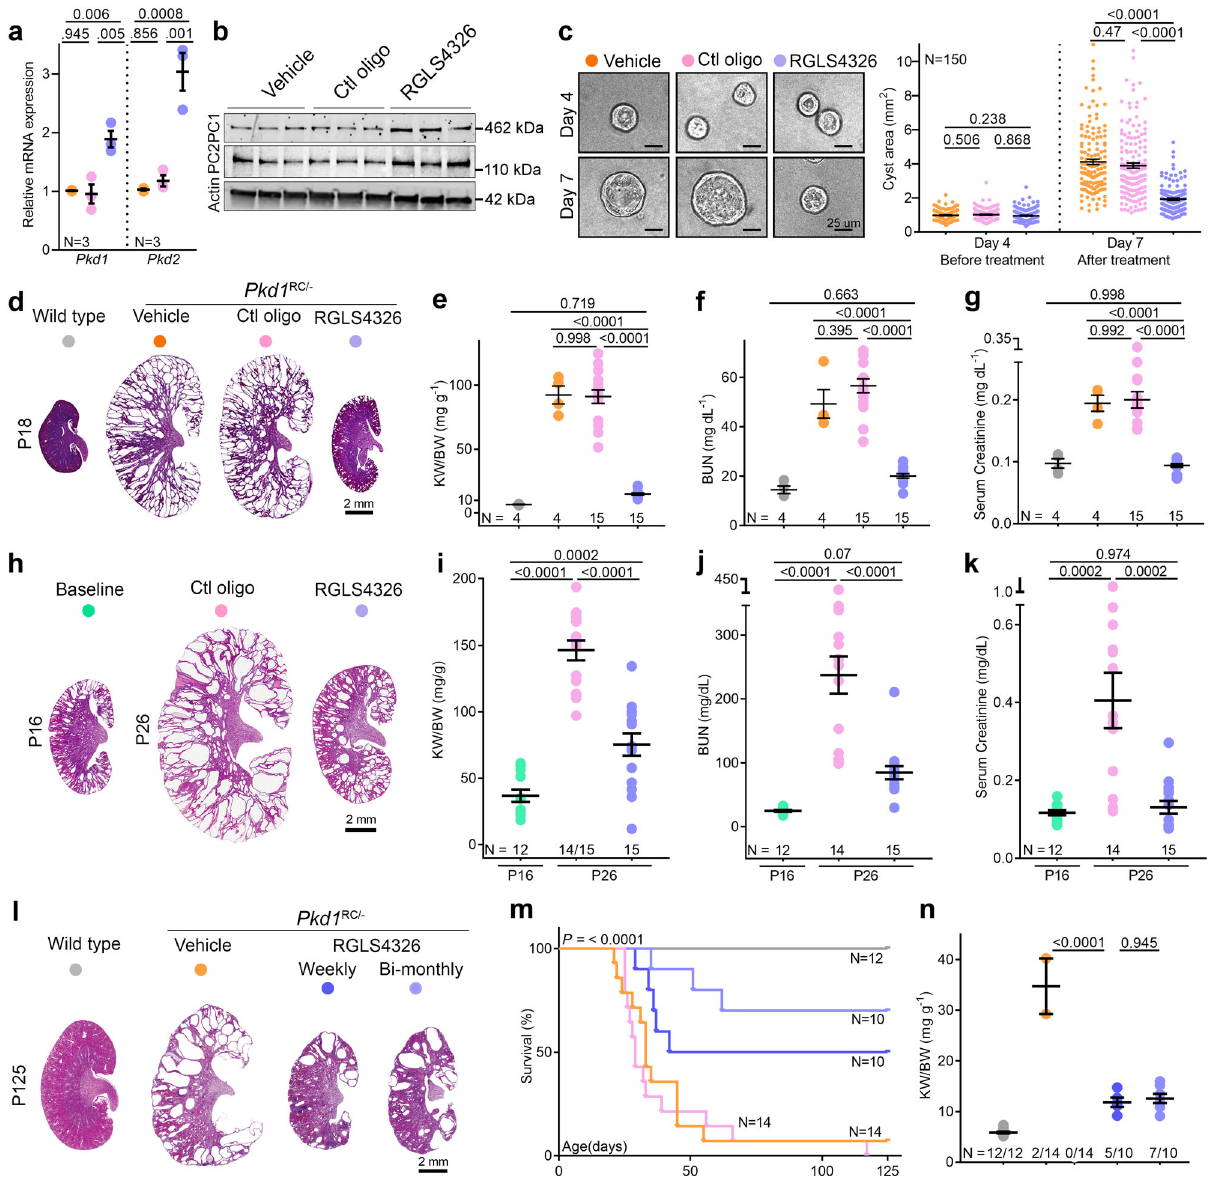
Fig. 5 | Acute Pkd1 and Pkd2 derepression attenuate PKD. a – b qRT-PCR and immunoblot analysis showing Pkd1 /PC1 and Pkd2 /PC2 expression in Pkd1 RC/- cells transfected with vehicle (PBS), 100 uM control oligonucleotide, or 100 uM RGLS4326. c Images and quanti fi cation of 3D cyst size of Pkd1 RC/- cells cultured in Matrigel before (day 4) or after (day 7) transfection with vehicle (PBS), 100 uM control oligonucleotide, or 100 uM RGLS4326. d H&E-stained kidney sections from 18-day-old Pkd1 RC/- mice injectedon P10, P11, P12, andP16 eitherwith vehicle (PBS), 20mg/kg control oligonucleotide, or 20mg/kg RGLS4326. H&E-stained kidney section from untreated 18-day-old wildtype mouse is shown forreference. e – g KW/BW, BUN, and serum creatinine levels in 18-day-old Pkd1 RC/- mice treated with vehicle (PBS), 20mg/kg control oligonucleotide, or 20mg/kg RGLS4326 are shown. Data from untreated 18-day-old wildtype mice are shown as a reference. h H&E-stained kidney sections from 26-day-old Pkd1 RC/- mice injected on P16 and P17 with 20mg/kg control oligonucleotide or 20mg/kg RGLS4326. H&E-stained kidney sections from genetically matched but untreated 16-day-old Pkd1 RC/-